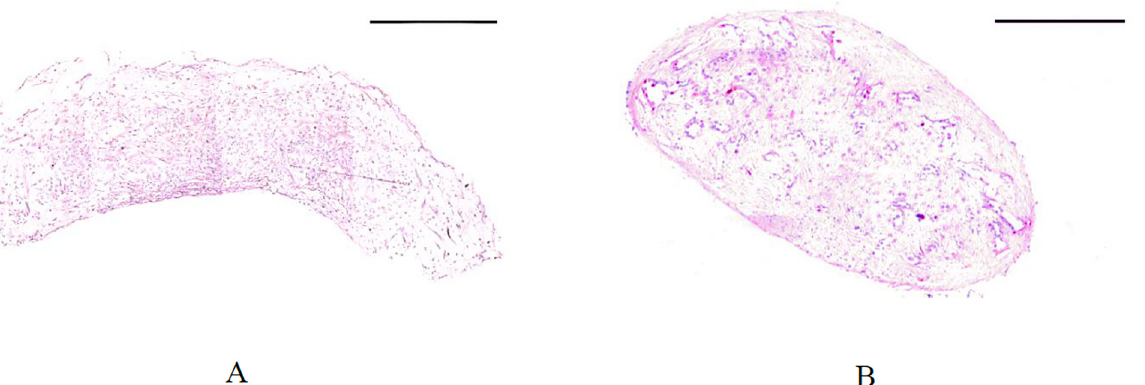
Fig 10. Hematoxylin and eosin staining of low (A) and high (C) aspect ratio TE sample after 3 weeks of culture. Both samples were compacted after 3 weeks. The scale bar represents 500 μ m.